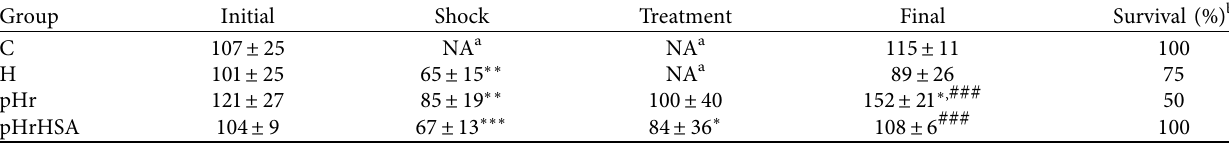
a Not applicable; b survivors after administration of treatment (at 24hours); values are expressed as mean ± SD; ( ∗ ) signifcant at p < 0 . 05, ( ∗∗ ) signifcant at p < 0 . 01, ( ∗∗∗ ) signifcant at p < 0 . 001 as compared with “Initial” values; (#) signifcant at p < 0 . 05, (##) signifcant at p < 0 . 01; (###) signifcant at p < 0 . 001 as compared with “Shock” values. Te t -test was